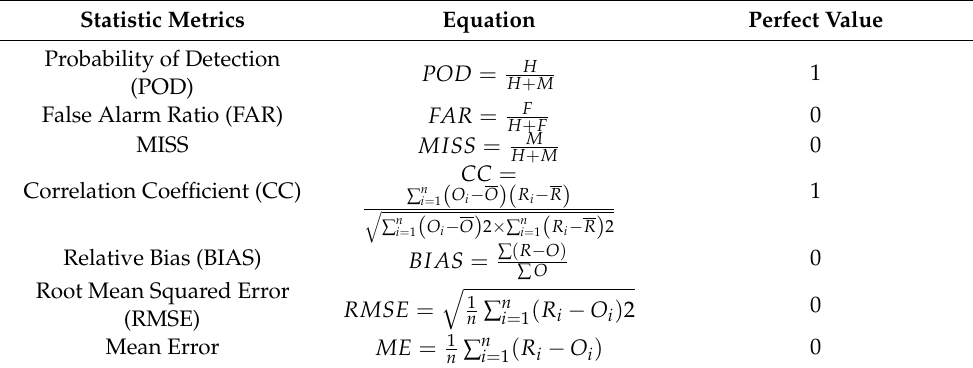
Table 2. Statistical metrics for evaluation used in this study a